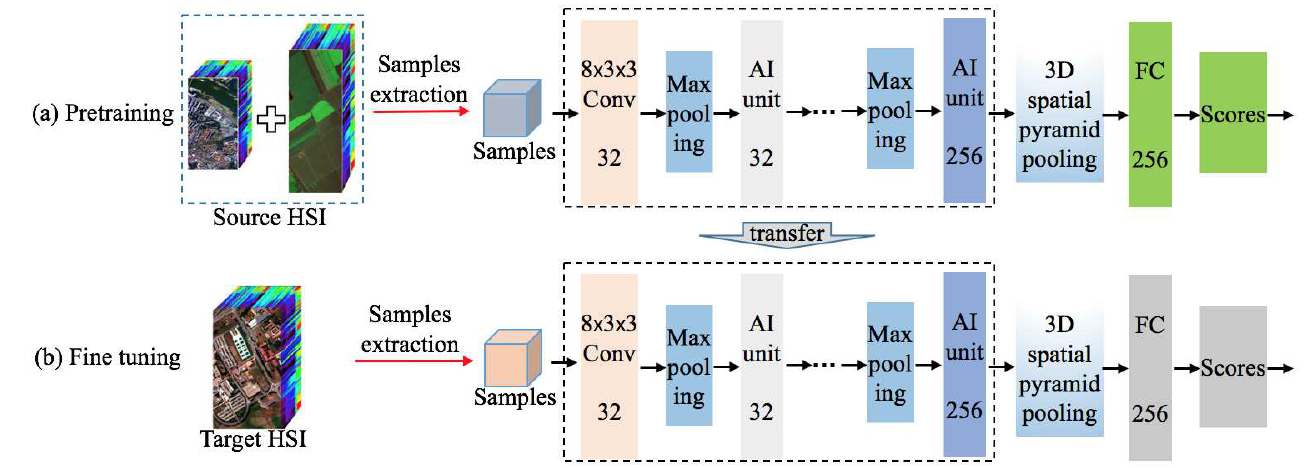
Figure 4. Data-fusion-based transfer learning. ( a ) Data-fusion pretraining: during pretraining, the proposed network is trained on two different HSI datasets for improving the diversity of samples and obtaining a robust initialized model. ( b ) Fine-tuning: after the pretrained model is acquired, the new model is initialized using the parameters of the pretrained model for the target HSI dataset. Here, the fully connected layers of the proposed model are randomly initialized with a Gaussian